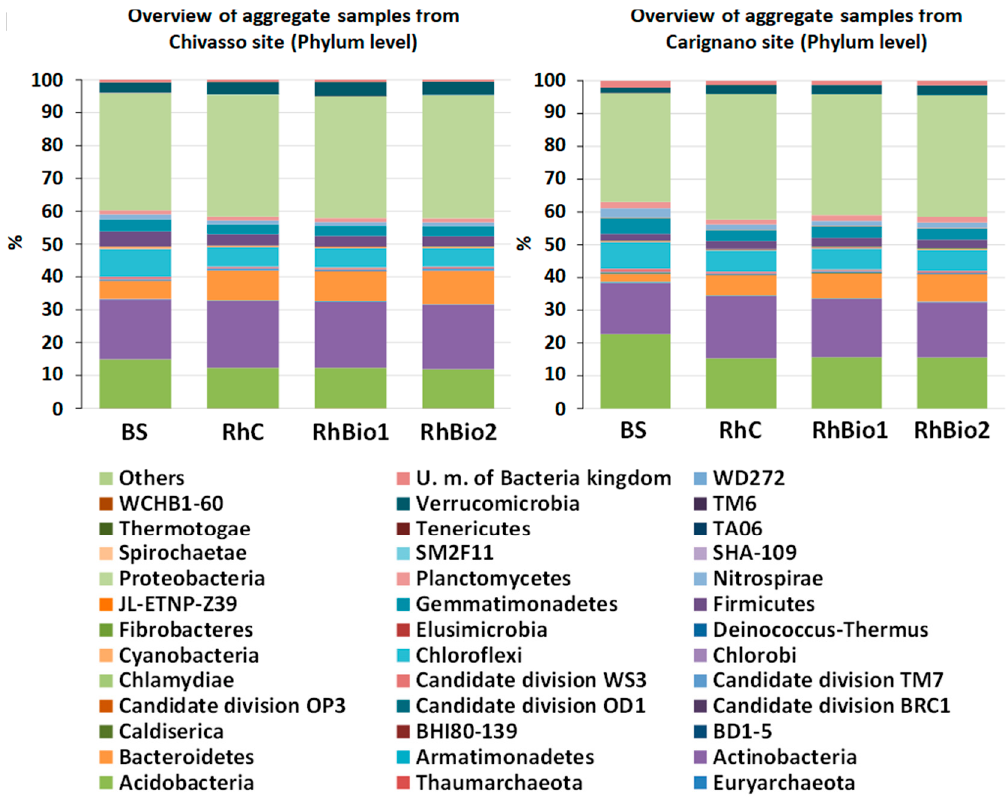
Figure 3. Taxonomic distribution at the phylum level based on 16S rDNA reads across the four sample types from the Carignano site (right) and the Chivasso site (left). BS = bulk soil; RhC = rhizosphere of control plants; RhBio1 = rhizosphere of plants from seeds coated with Bio1; RhBio2 = rhizosphere of plants from seeds coated with Bio2.